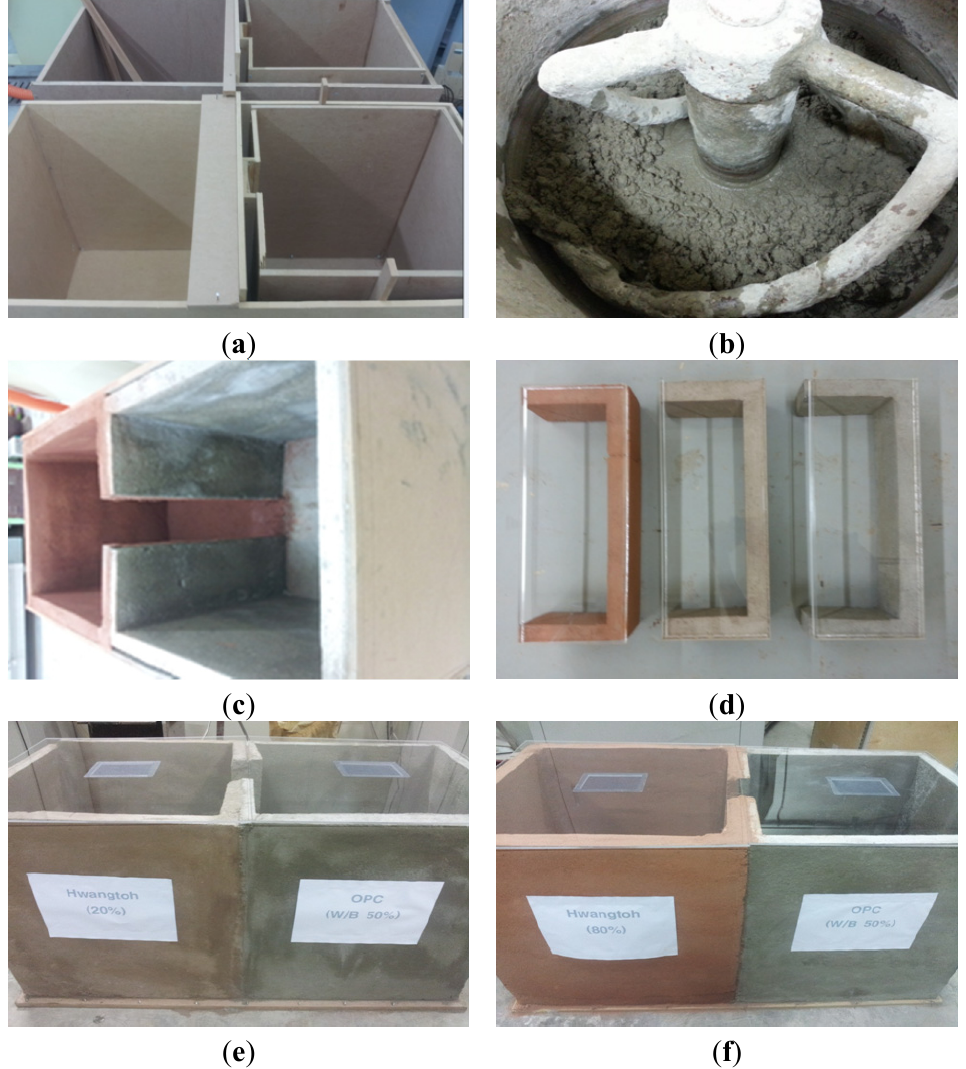
Figure 8. Residence cage photos and specimen types. ( a ) Residence cage forms; ( b ) Concrete mixing; ( c ) Casting and curing; ( d ) Sleeping spaces; ( e ) 20% Hwangtoh and OPC mortar, and ( f ) 80% Hwangtoh and OPC mortar.